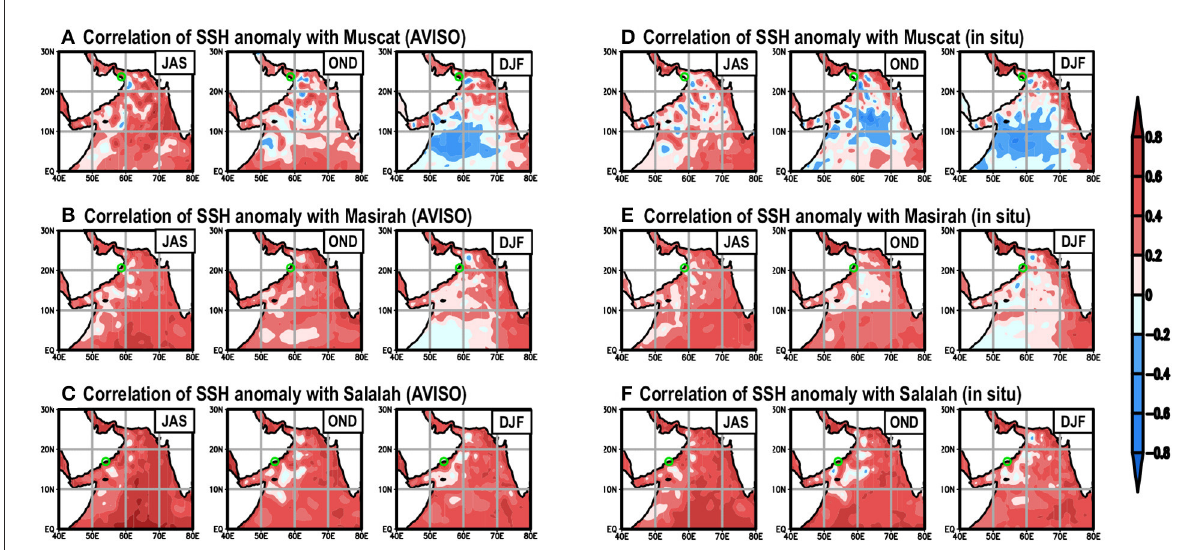
FIGURE2 (A) Correlation maps of AVISO-derived SSH anomalies with the AVISO-derived SSH at Muscat B observatory in July–September, October–December, and December–February. Plotted values are calculated using the data in the period when the in situ data are available. A green circle denotes the location of the Muscat B observatory. (B,C) Are as in (A) , but show the correlations with AVISO-derived SSH at the Masirah and Salalah observatories, respectively. Green circles denote the location of Masirah and Salalah, respectively. (D–F) Are the same as in (A–C) , respectively, except for the correlations with the in situ SSH data.